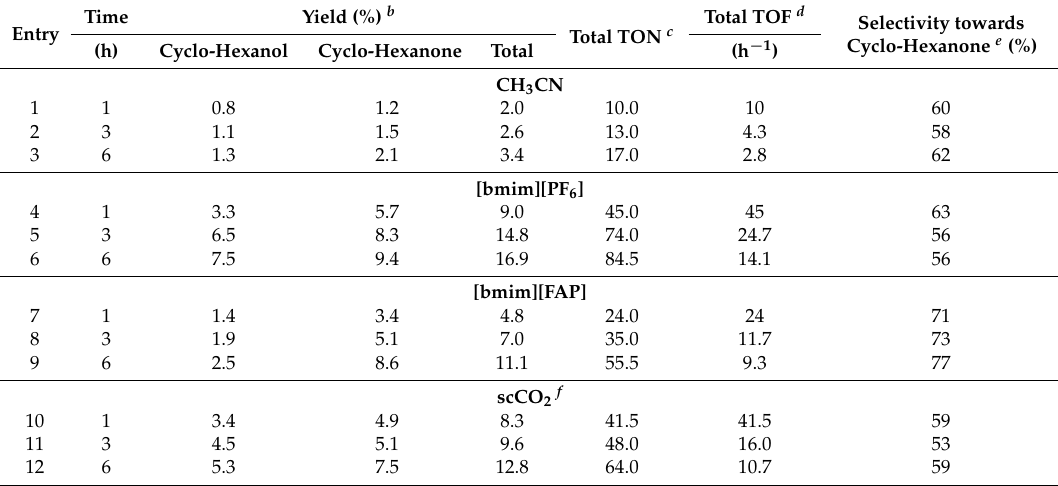
Table 2. Selected data a for the cyclohexane oxidation with TBHP using [FeCl 2 {HOCH 2 C(pz) 3 }] 2 as a catalyst. Entry